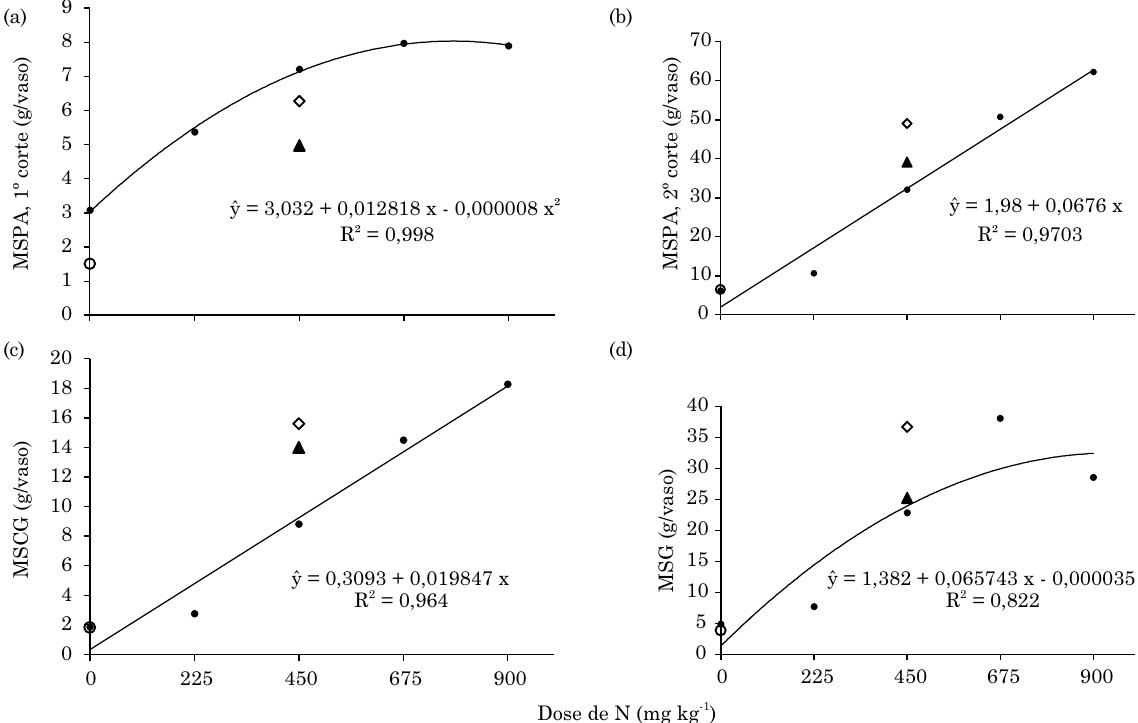
Figura 4. produção de matéria seca da parte aérea (mspa) no 1º corte (a), no 2º corte (b), nas cascas dos grãos (msCg) (c) e nos grãos (msg) (d) em plantas de arroz submetidas a doses de nitrogênio via colágeno de curtume e três tratamentos adicionais, cultivadas em Latossolo Vermelho Distrófico